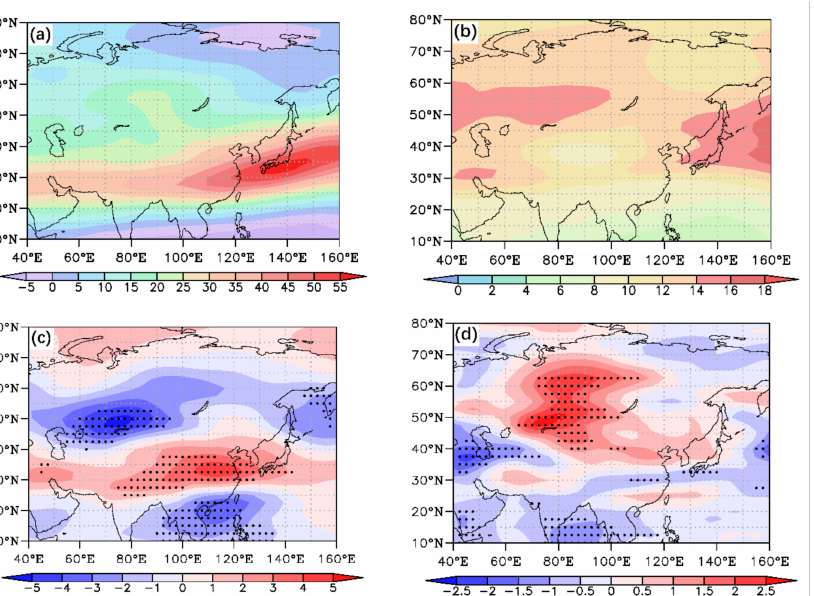
Figure 5. ( a ) The 300 hPa zonal mean wind field in climatological mean winter; ( b ) the standard deviation of 300 hPa daily zonal wind field in climatological mean winter; ( c ) the deviation of 300 hPa mean zonal wind field in WPECE winter; ( d ) the standard deviation anomaly of 300 hPa mean zonal wind field in WPECE winter (units: m/s). The doted regions are for values significant at or above the 95% confidence